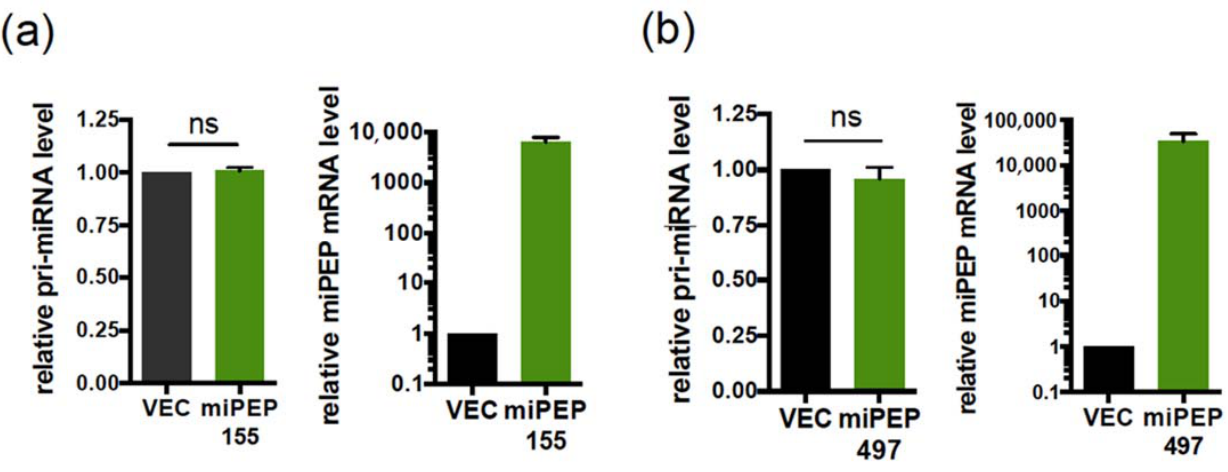
Figure 2. The miPEP155 and miPEP497 do not regulate the levels of their corresponding pri-miRNA. ( a , b ) Left: Expression of endogenous pri-miR-155 ( a ) or pri-miR-497 ( b ) upon overexpression of miPEP155 ( a ) or miPEP497 ( b ) into Hela cells. Pri-miRNA levels, quantified by quantitative RT-PCR, were normalized to GAPDH and set to 1 for the control vector (VEC) transfected cells. Data are means ± S.E.M. of three ( a ) or four ( b ) independent experiments. The right panels confirm the overexpression of miPEPs in transfected Hela cells. ns: not significant.